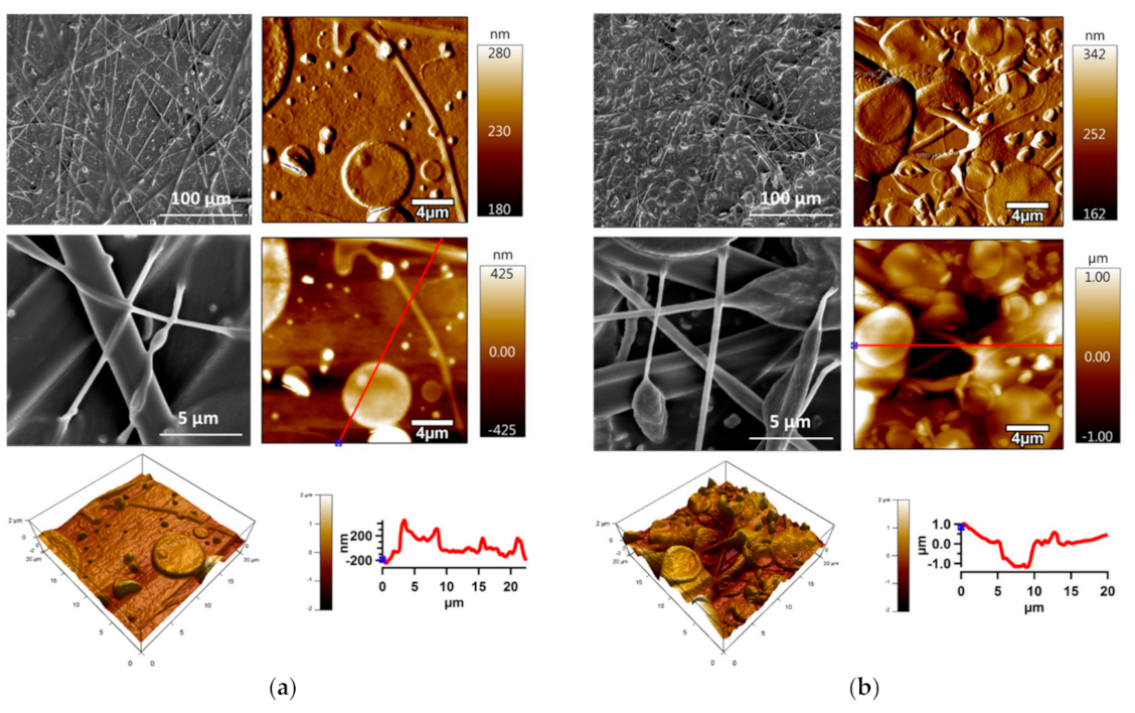
Figure 8. SEM and AFM images of: ( a ) PDMS/PA/BSO-PE, ( b ) PDMS/PA/BSO-PU.